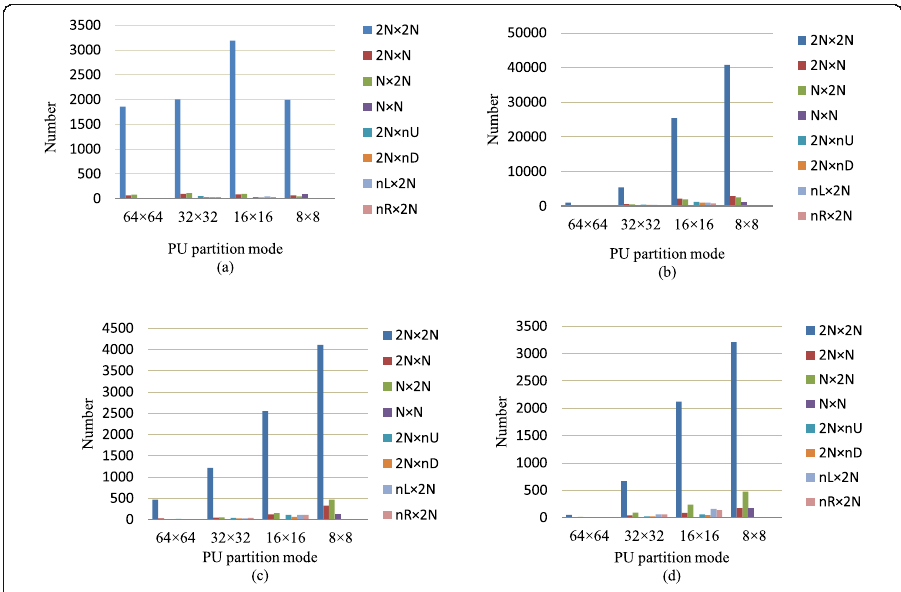
Fig. 3 Distribution of PU partition modes for videos with different resolutions. a BasketballDrive_1920 ×